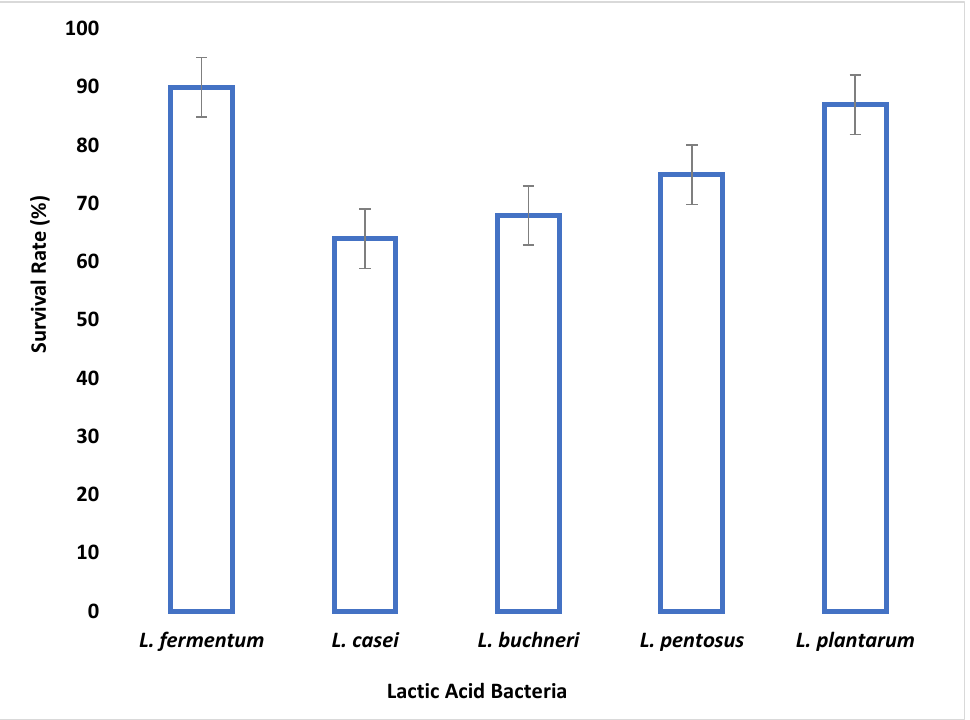
Figure 7. All lactic acid bacteria isolates were able to tolerate simulated gastric juice but L. fermentum had the highest survival